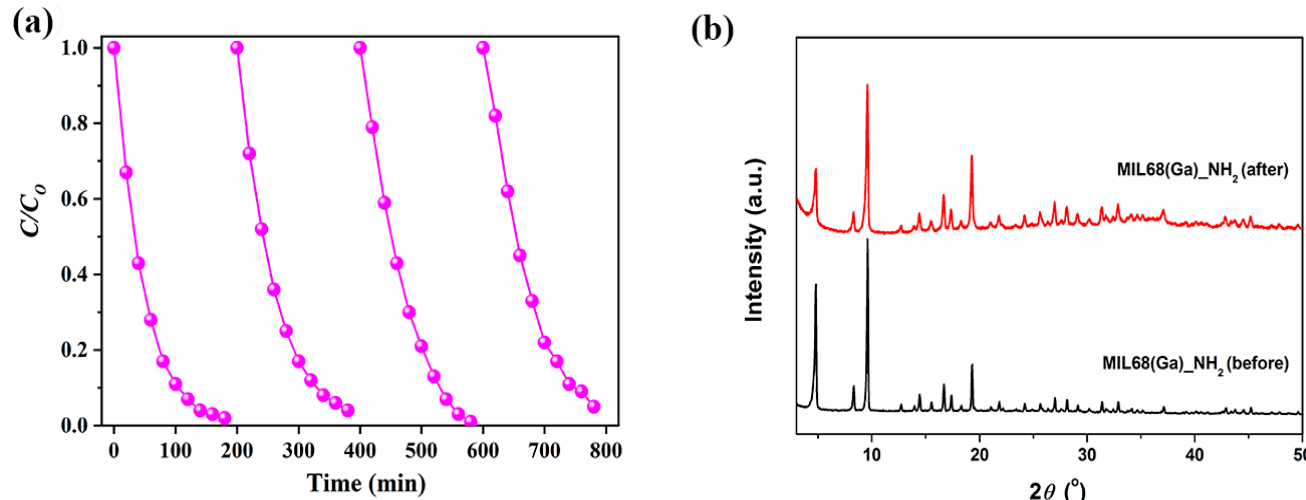
Figure 6. ( a ) Changes of the Cr(VI) concentration during the four repeated processes over MIL–68(Ga)_NH 2 . ( b ) PXRD patterns of MIL–68(Ga)_NH 2 before (black) and after (red) reduction Cr(VI) for 180 min prolonged reaction.